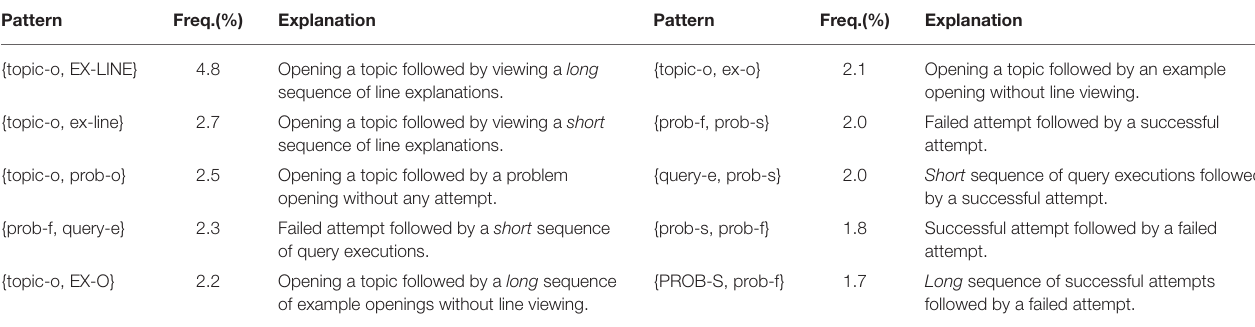
TABLE 3 | Discovered top 10 frequent patterns with sequence explanations and frequency of occurrence. Pattern Freq.(%) Explanation Pattern Freq.(%) Explanation Opening a topic followed by viewing a long sequence of line